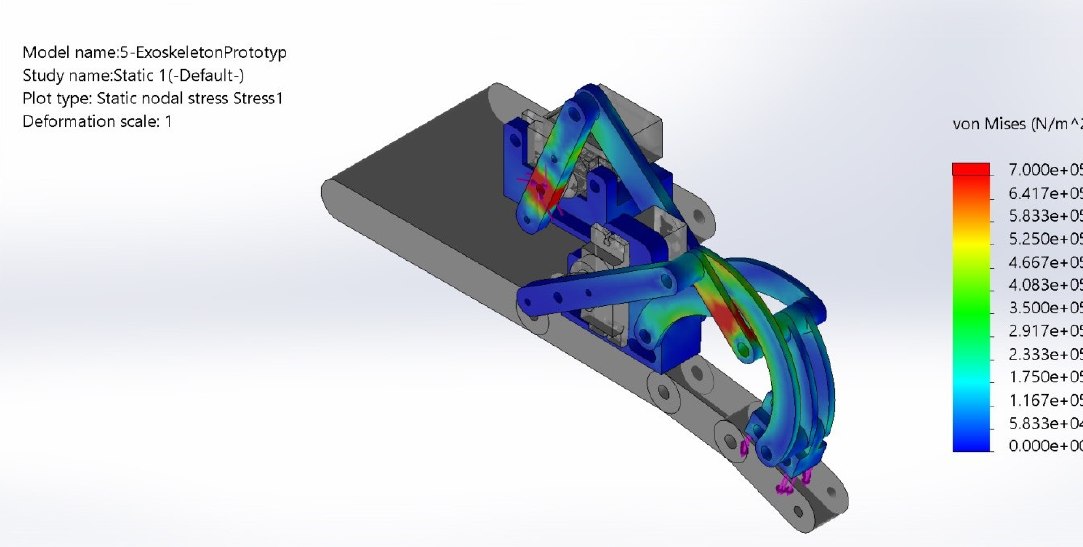
Figure 16. Static nodal FEM analysis of the whole prototype.